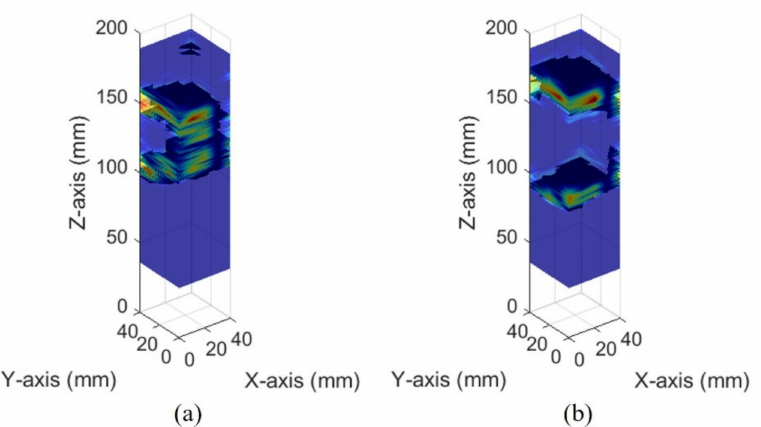
Figure 10. Ultrasound pulse-echo 3-D images of the pig bladder walls: ( a ) 50 mL and ( b ) 300 mL.